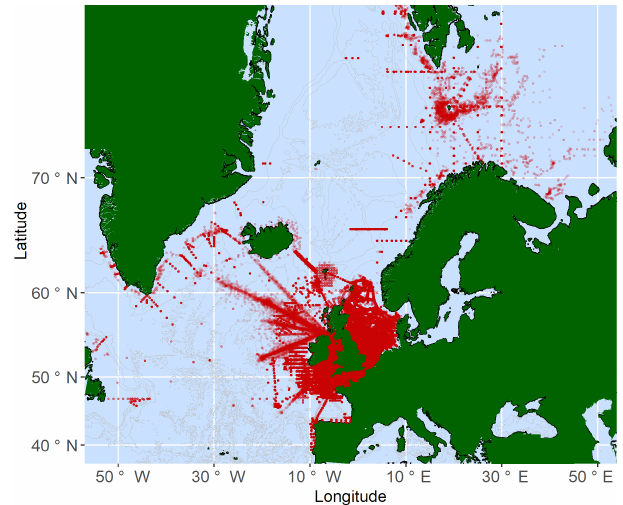
Figure 3. Overview of the locations of Cefas seawater temperature measurements with plotted point intensity reflecting data